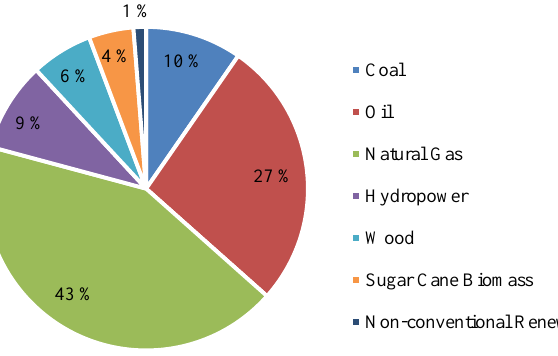
Fig. 1. Internal demand of primary energy resources in 2016